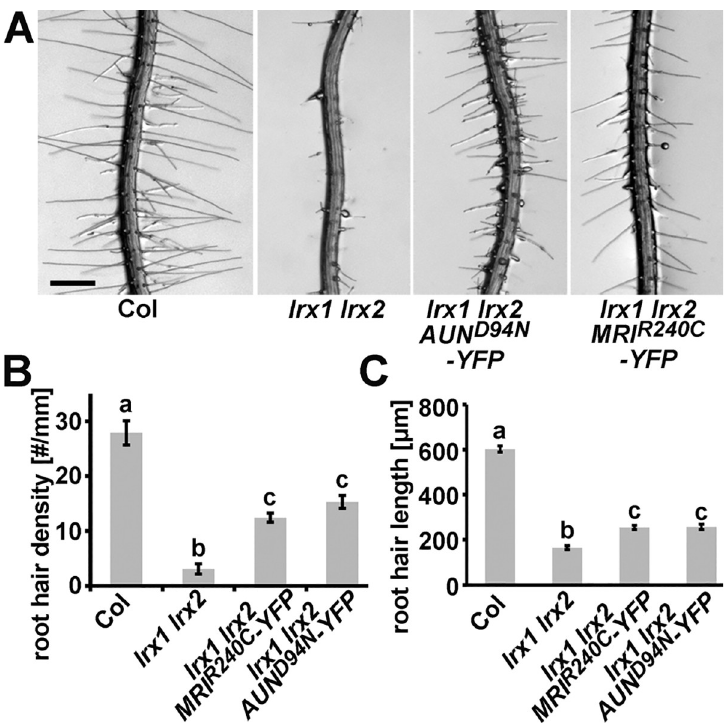
Fig 7. Expression of AUN1 D94N and MRI R240C partially suppress the lrx1 lrx2 root-hair defect. (A) Root hair phenotypes of the wild type (Col), lrx1 lrx2 double mutant, and representative examples of several independent transgenic lrx1 lrx2 double mutant expressing either pMRI : AUN1 D94N -YFP or pMRI : MRI R240C -YFP . Seedlings were grown for 5 days on half-strength MS in a vertical orientation. Quantification of the rescue by assessing root hair density (B) and root hair length (C) in the different lines. Seedlings were grown for 5 days on half-strength MS in a vertical orientation. Error bars represent SEM; different letters above the graphs indicate significant differences (T-test, N = 50, P < 0.01). Bar = 0.5